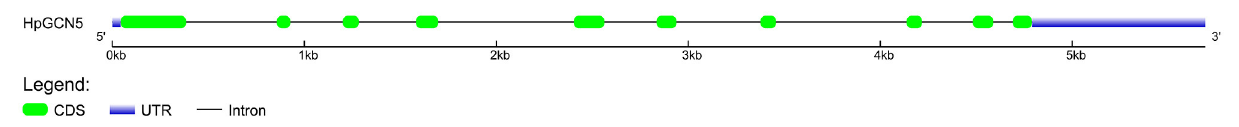
PF00439), as AtGCN5 and ScGCN5 did. Hence, Gene005060 and Gene010338 were selected as the candidates for HpGCN5